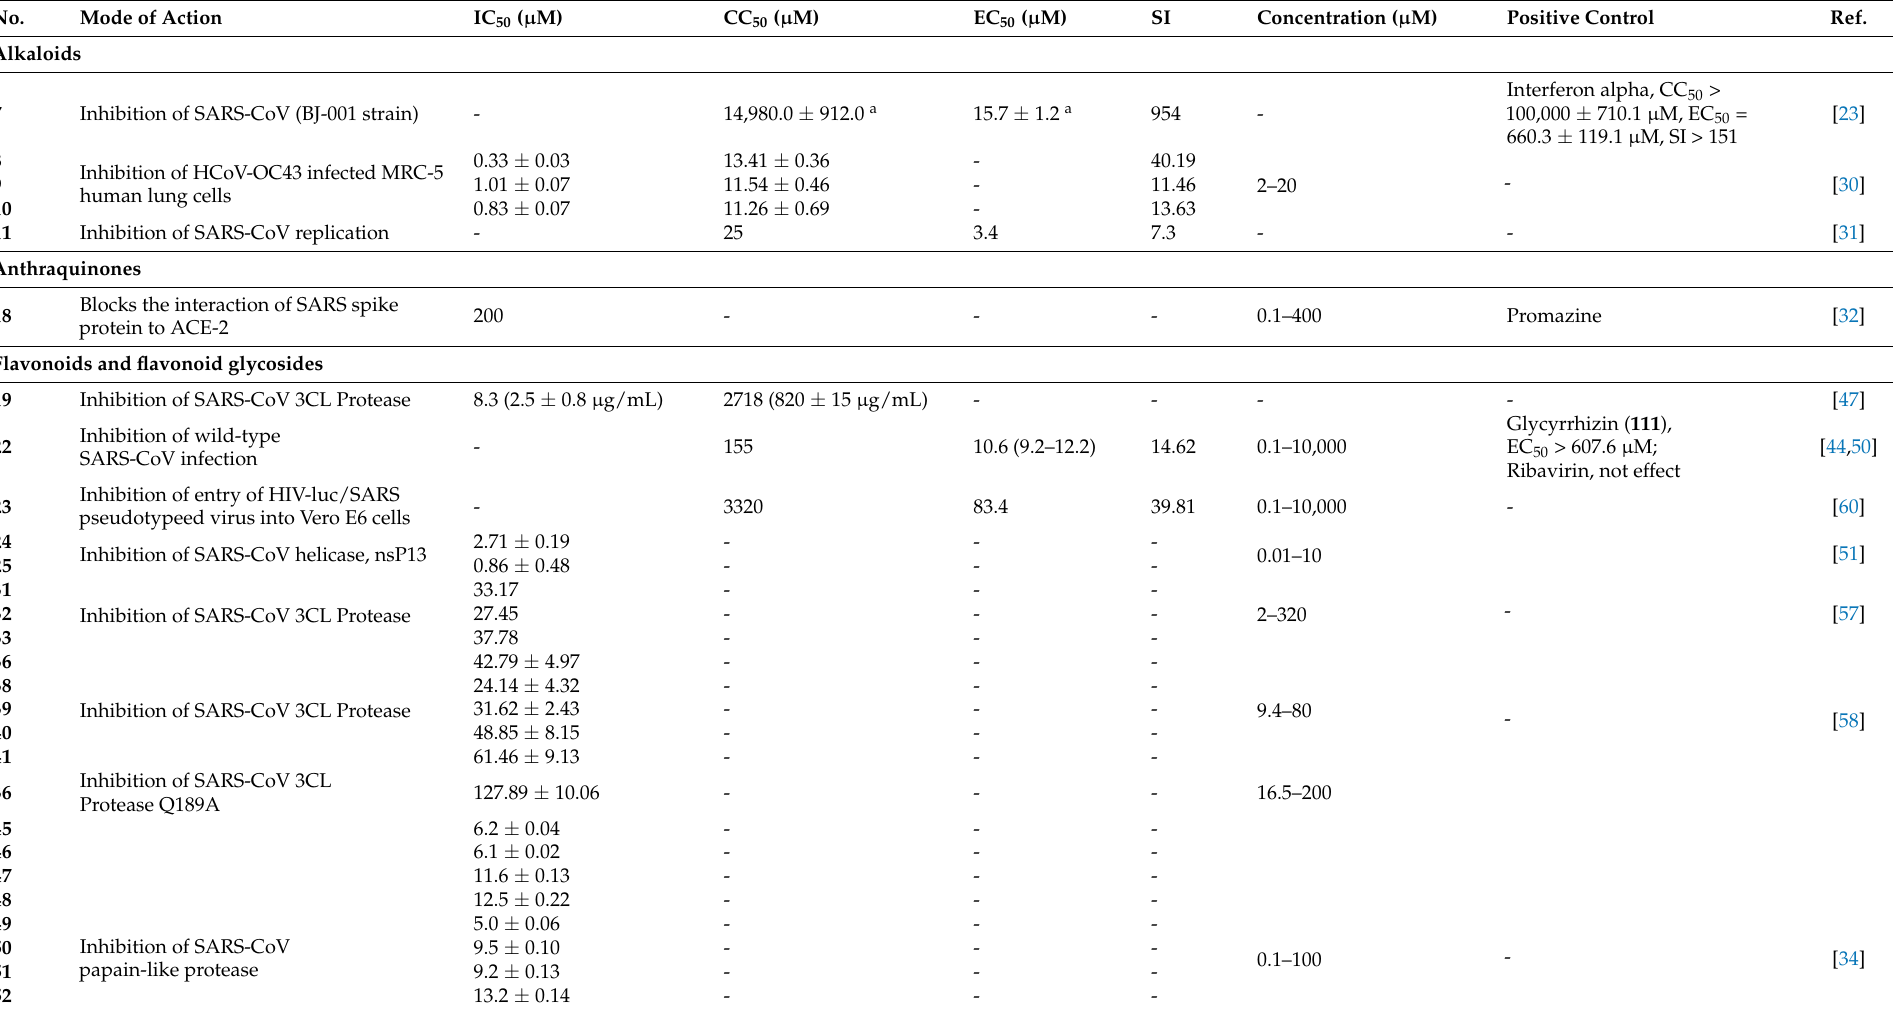
Table 2. Anti-Human Coronavirus (Anti-HCoV) activities of natural